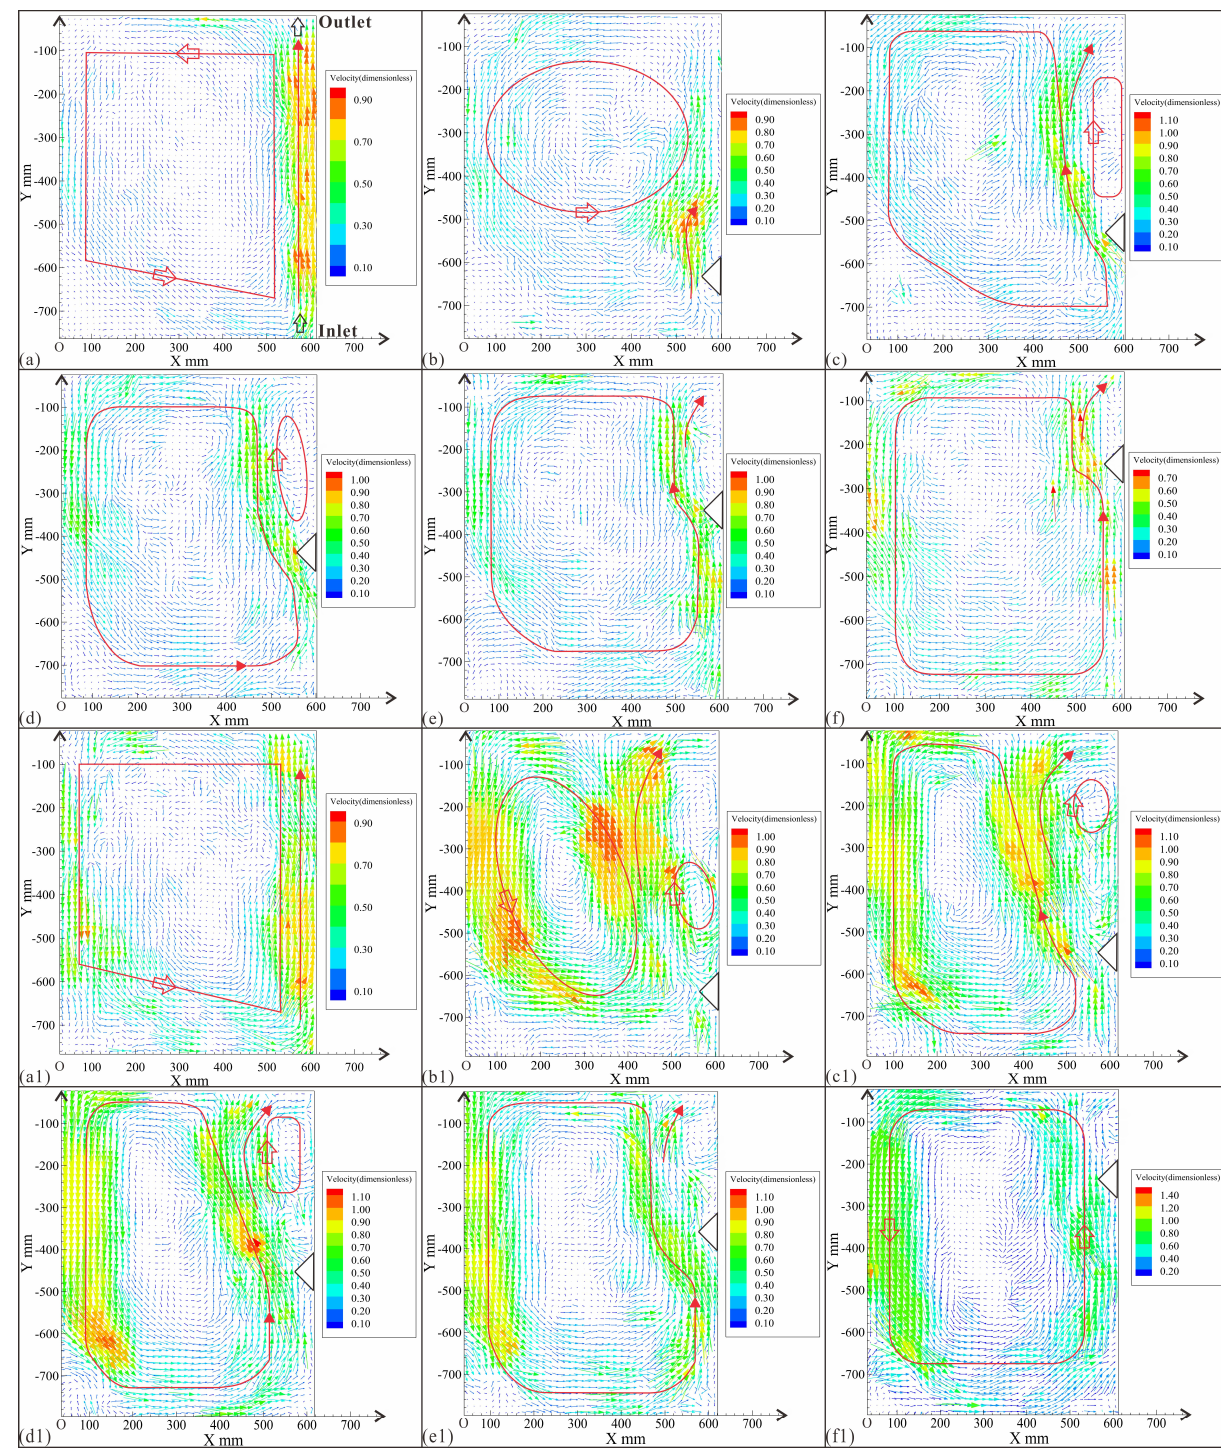
Figure 5. Vector distribution of the flow field under the influence of the triangular prism for Q = 3.7 L/min and 6.8 L/min, respectively: ( a – f ) for 3.7 L/min; ( a1 – f1 ) for 6.8 L/min. Vector distribution ( a , a1 ) for no structure; ( b , b1 ) for l = 0.19; ( c , c1 ) for l = 0.31; ( d , d1 ) for l = 0.44; ( e , e1 ) for l = 0.56; ( f , f1 ) for l = 0.69.